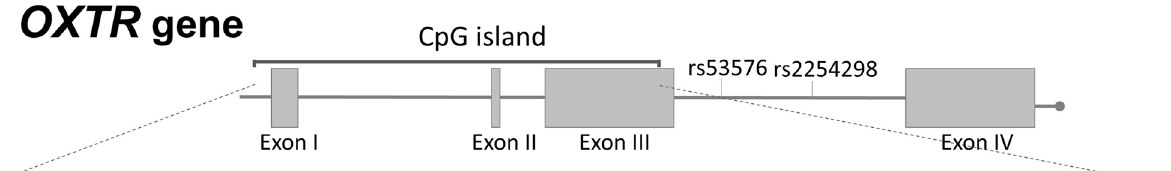
Fig. 1 Schematic view of the targeted sequence of the OXTR gene. All CpG units located within the targeted sequence (GRCh37/hg19, chr3:8809305-8811438, sequence shown 3' to 5') are numbered consecutively. Underlined are the CpG sites that were included for analyses after data cleaning for the analyses in mothers. Thereafter, 133 CpG sites remained from maternal samples and 142 from children (in contrast to maternal analyses, the CpG 21, CpG 40.41, and CpG 115.116.117.118.119.120 remained for children ’ s analyses after applying the quality